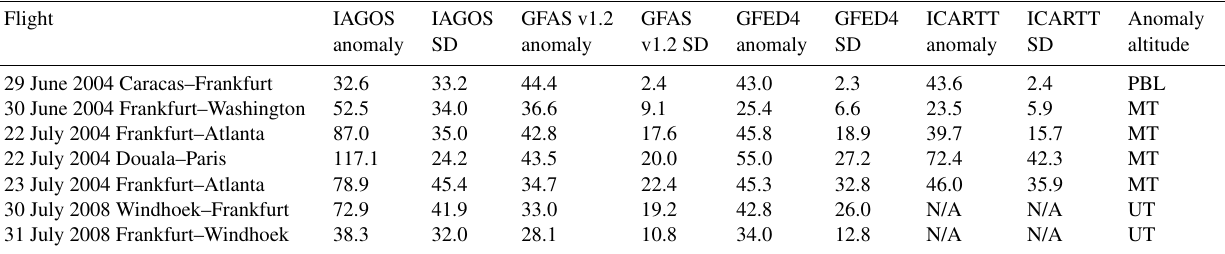
Figure 13. Comparison of the SOFT-IO biomass burning emission influence between 2003 and 2013. Taylor diagrams are obtained for the different regions and in the three vertical layers (LT, MT and UT) using (a) GFAS v1.2 (dots) and GFED4 (crosses) with MACCity and MIXED methodology for both GFAS v1.2 and GFED4 (lines represent connections between the two inventories) and (c) GFAS v1.2 and MACCity with different vertical fire injections methodologies: MIXED (dots), APT (plus) and DENTENER (crosses) (lines represent connections between the two inventories). Mean biases between modeled and observed CO anomalies. Model is using (b) GFAS v1.2 + MACCity (blue), GFED4 + MACCity (brown) and MIXED methodology for both GFAS v1.2 and GFED4. (d) GFAS v1.2 + MACCity and different vertical fire injections methodologies: MIXED (blue); APT (green) and DENTENER (brown). Table 4. Summary of the averaged observed and simulated anomaly and corresponding averaged standard deviation (SD) (in ppb) determined for representing biomass burning emissions for different case studies (using MACCity for anthropogenic emissions). Altitude of the anomaly is indicated: boundary layer (PBL); middle troposphere (MT); upper troposphere (UT). Note that the ICARTT inventory is only available for summer